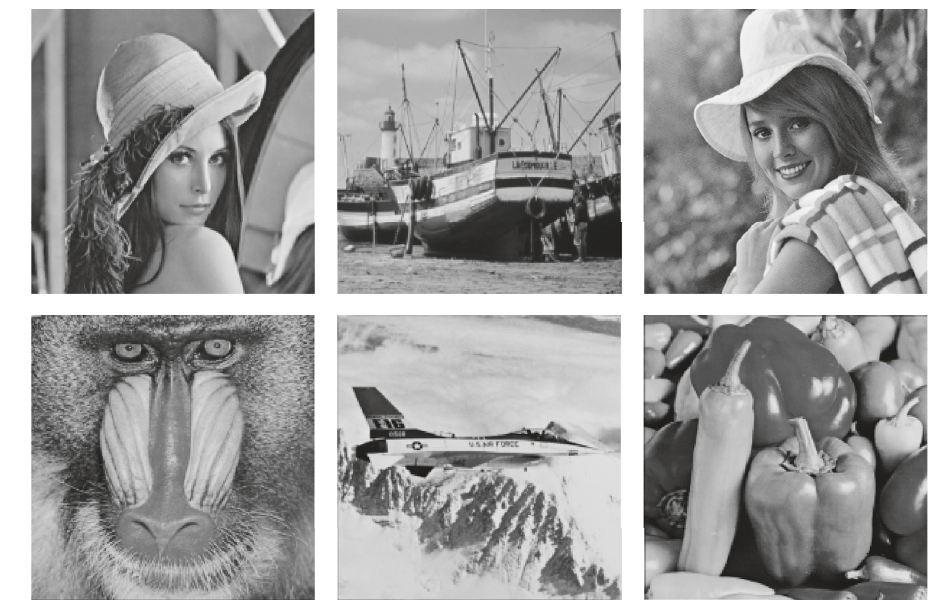
Figure 4: Tested images: Lena, Boat, Elaine, Baboon, Jet, and